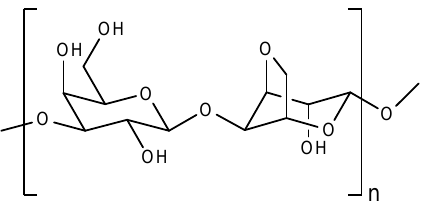
Figure 12. The structure of agarose.